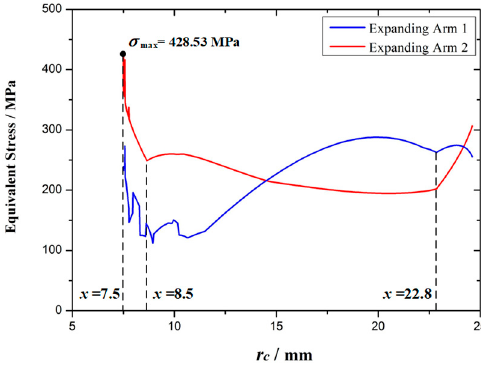
Micromachines 2019 , 10 , x FOR PEER REVIEW Figure 12. The curves of the equivalent stress. Figure 12. The curves of the equivalent stress.